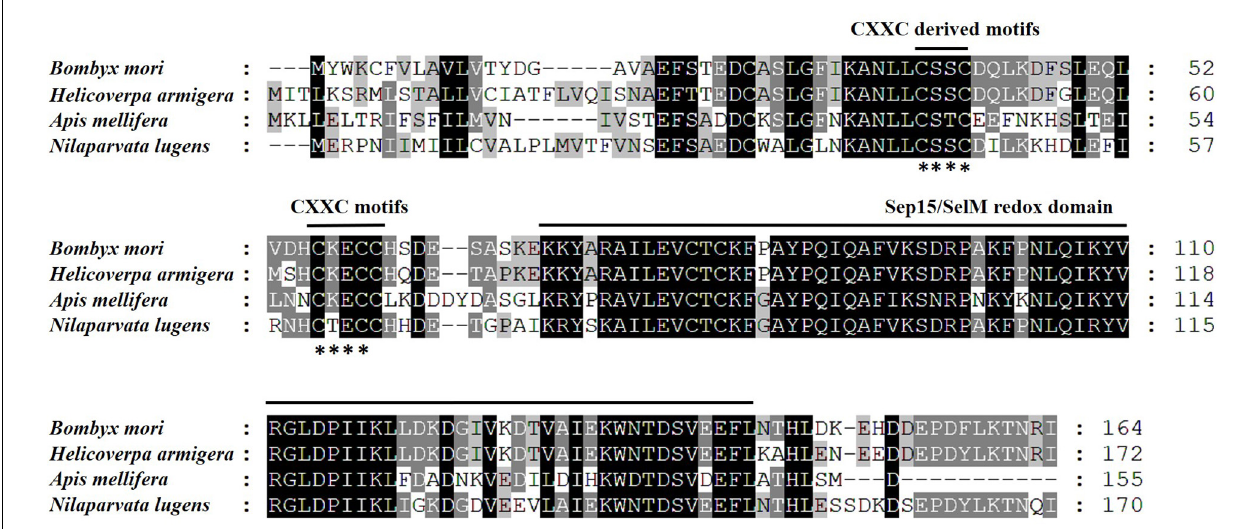
FIGURE 3 | Amino acid sequence alignment of SPFs of B. mori , H. armigera , A. mellifera , and N. lugens using CLUSTAL X. Letters shaded in black and gray indicate the identical and similar amino acid residues, respectively; asterisk ( ∗ ) indicates conserved CXXC-motifs or CXXC-derived